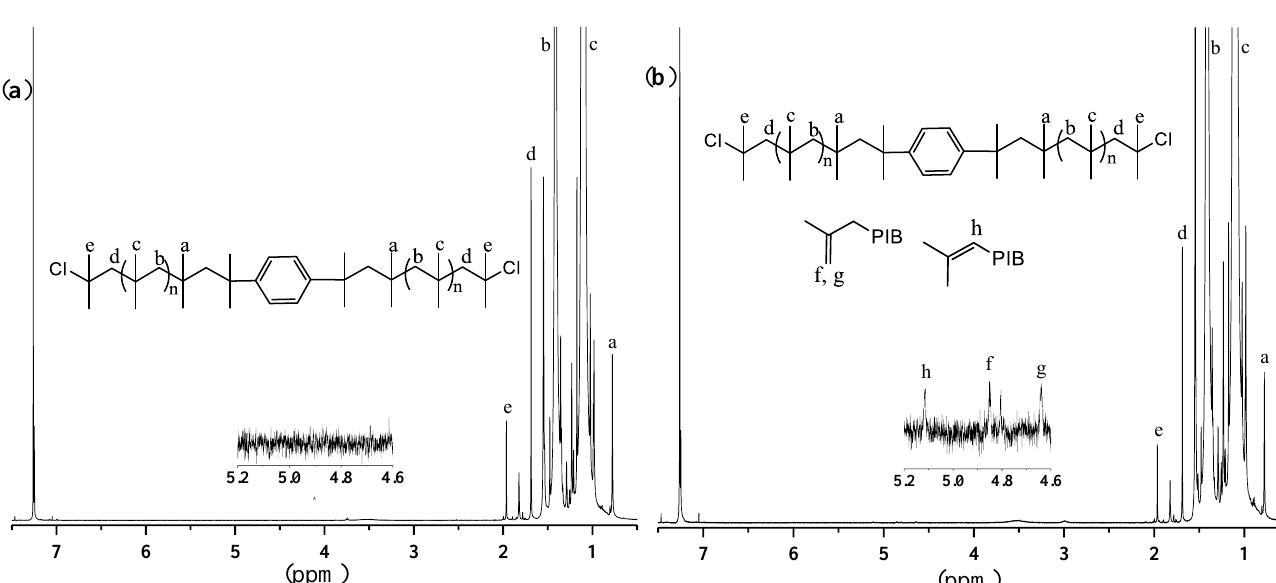
Figure 2. 1 H NMR spectrum of PIB prepared with DiCumCl/TiCl 4 /Lu initiating system ( a ) at high initiator concentration ([DiCumCl] = 2.8 mM; [Lu] = 5.8 mM) and ( b ) at high concentration of proton trap ([DiCumCl] = 1.4 mM; [Lu] = 23.4 mM).